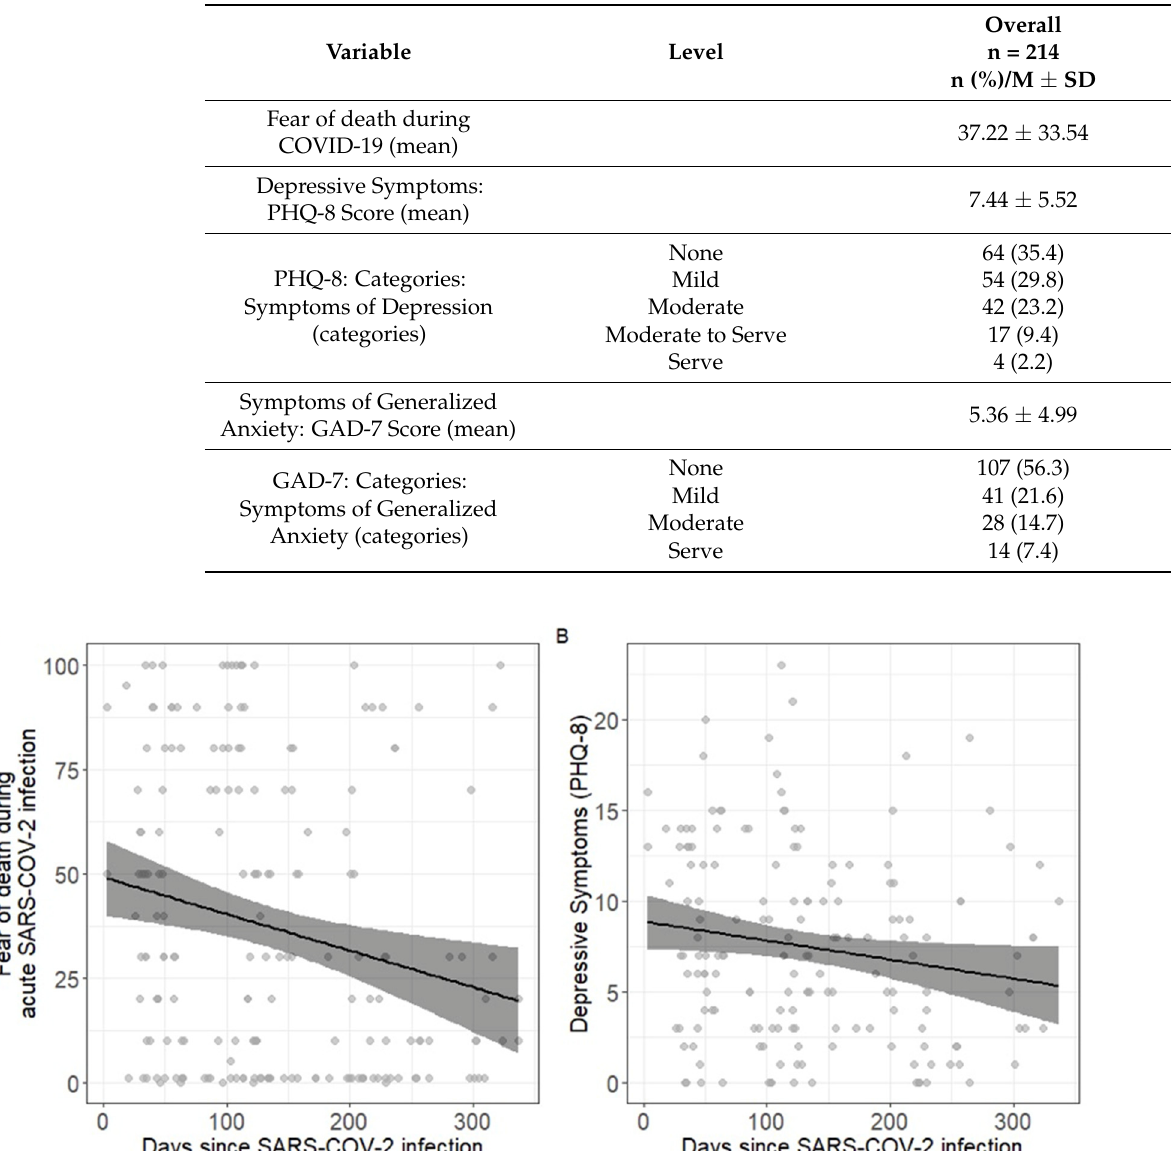
Table 2. The severity of retrospectively assessed fear of death during COVID-19, as well as the prevalence of depressive symptoms (PHQ-8) and symptoms of generalized anxiety (GAD-7) at the time of presentation to the outpatient clinic. Values are presented as n (percent) or means ± SD.